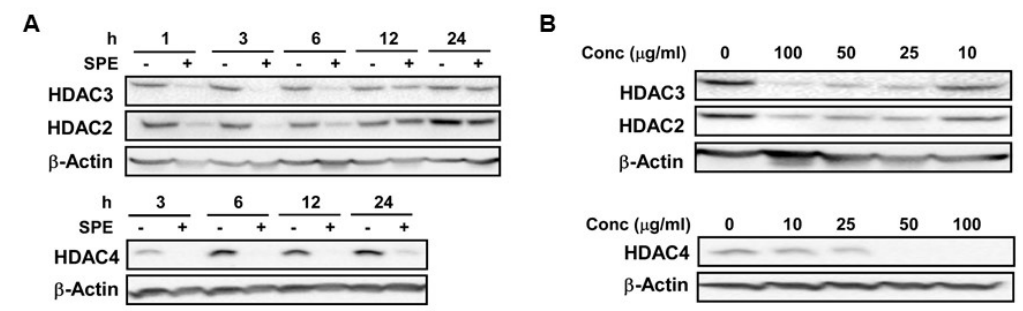
Figure 2. SPE reduced HDAC proteins in a dose and time-dependent manner in bone marrow-derived macrophages (BMDM). ( A ) Western blot analysis of HDAC2, 3, and 4 in BMDM treated with 100 µ g/mL of SPE for indicated amount of time; ( B ) Western blot analysis of HDAC2, 3, and 4 in BMDM treated with indicated concentration of SPE for 3 h. A representative blot of 2–3 experiments is